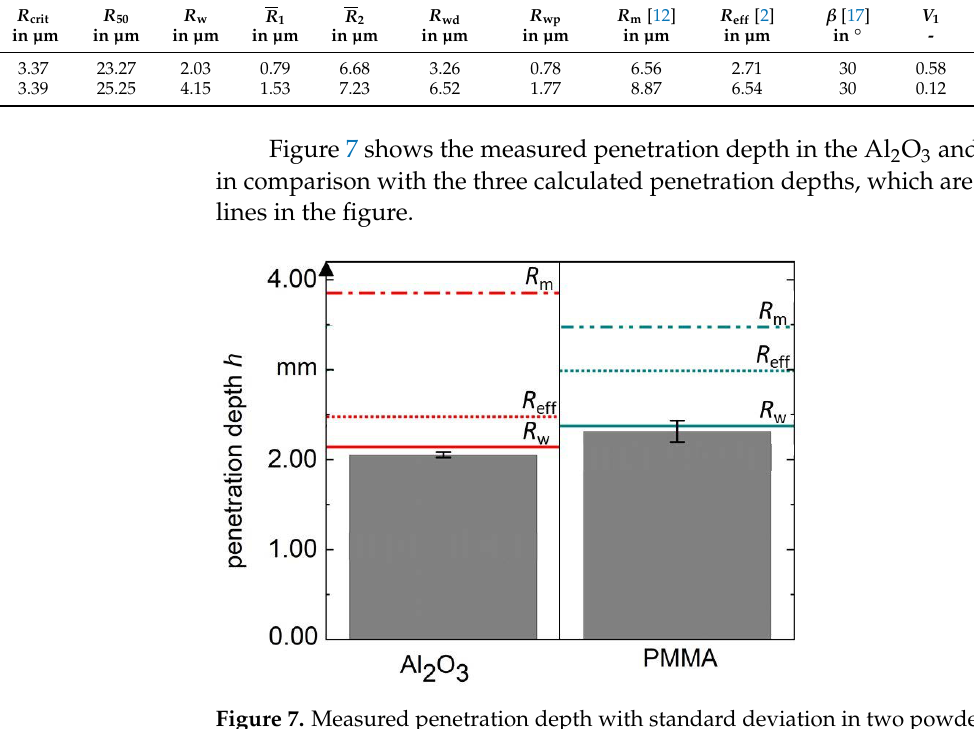
Figure 7. Measured penetration depth with standard deviation in two powders (Al 2 O 3 and PMMA) compared to the calculated penetration depth with three different approaches shown by the horizontal lines: the median pore radius R m determined from the pore size distribution, the effective radius R eff , analogous to Barui et al. [2], and the weighted pore radius R w , determined in this